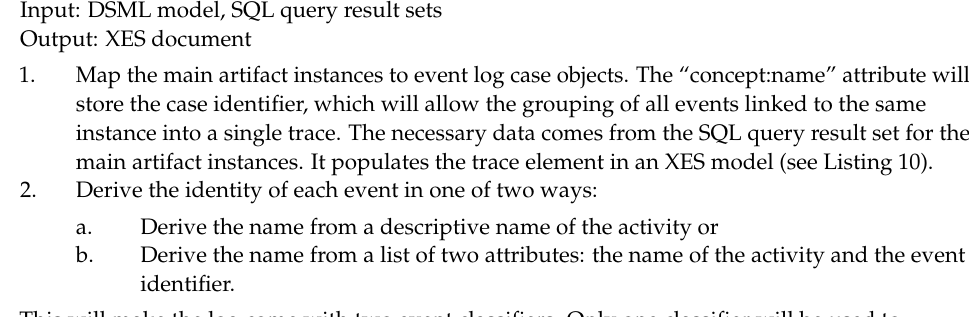
Algorithm 1 Mapping the DSML model into an XES